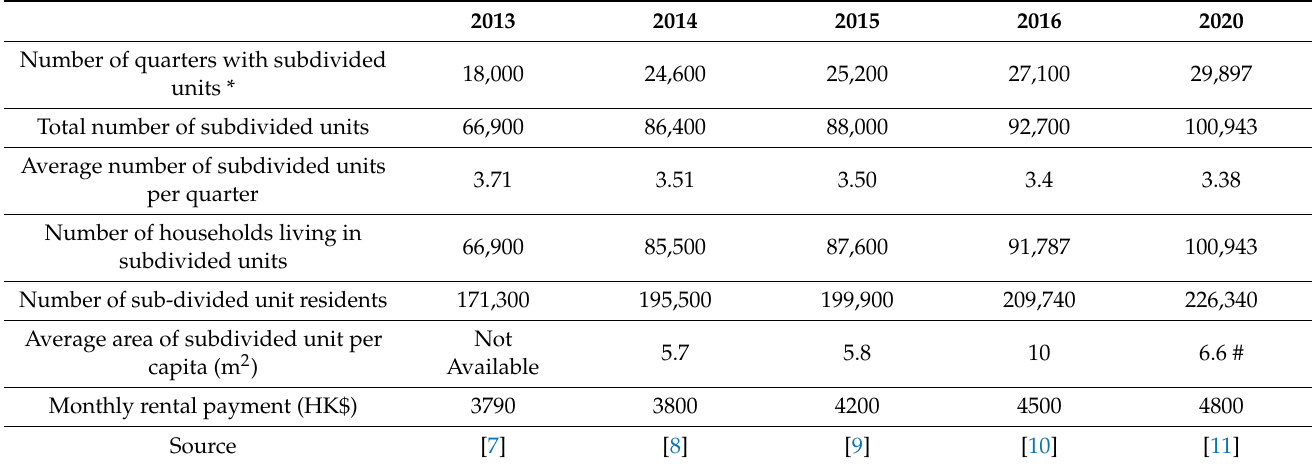
Table 1. Estimated Number of Subdivided Units in Hong Kong (2013–2016 and